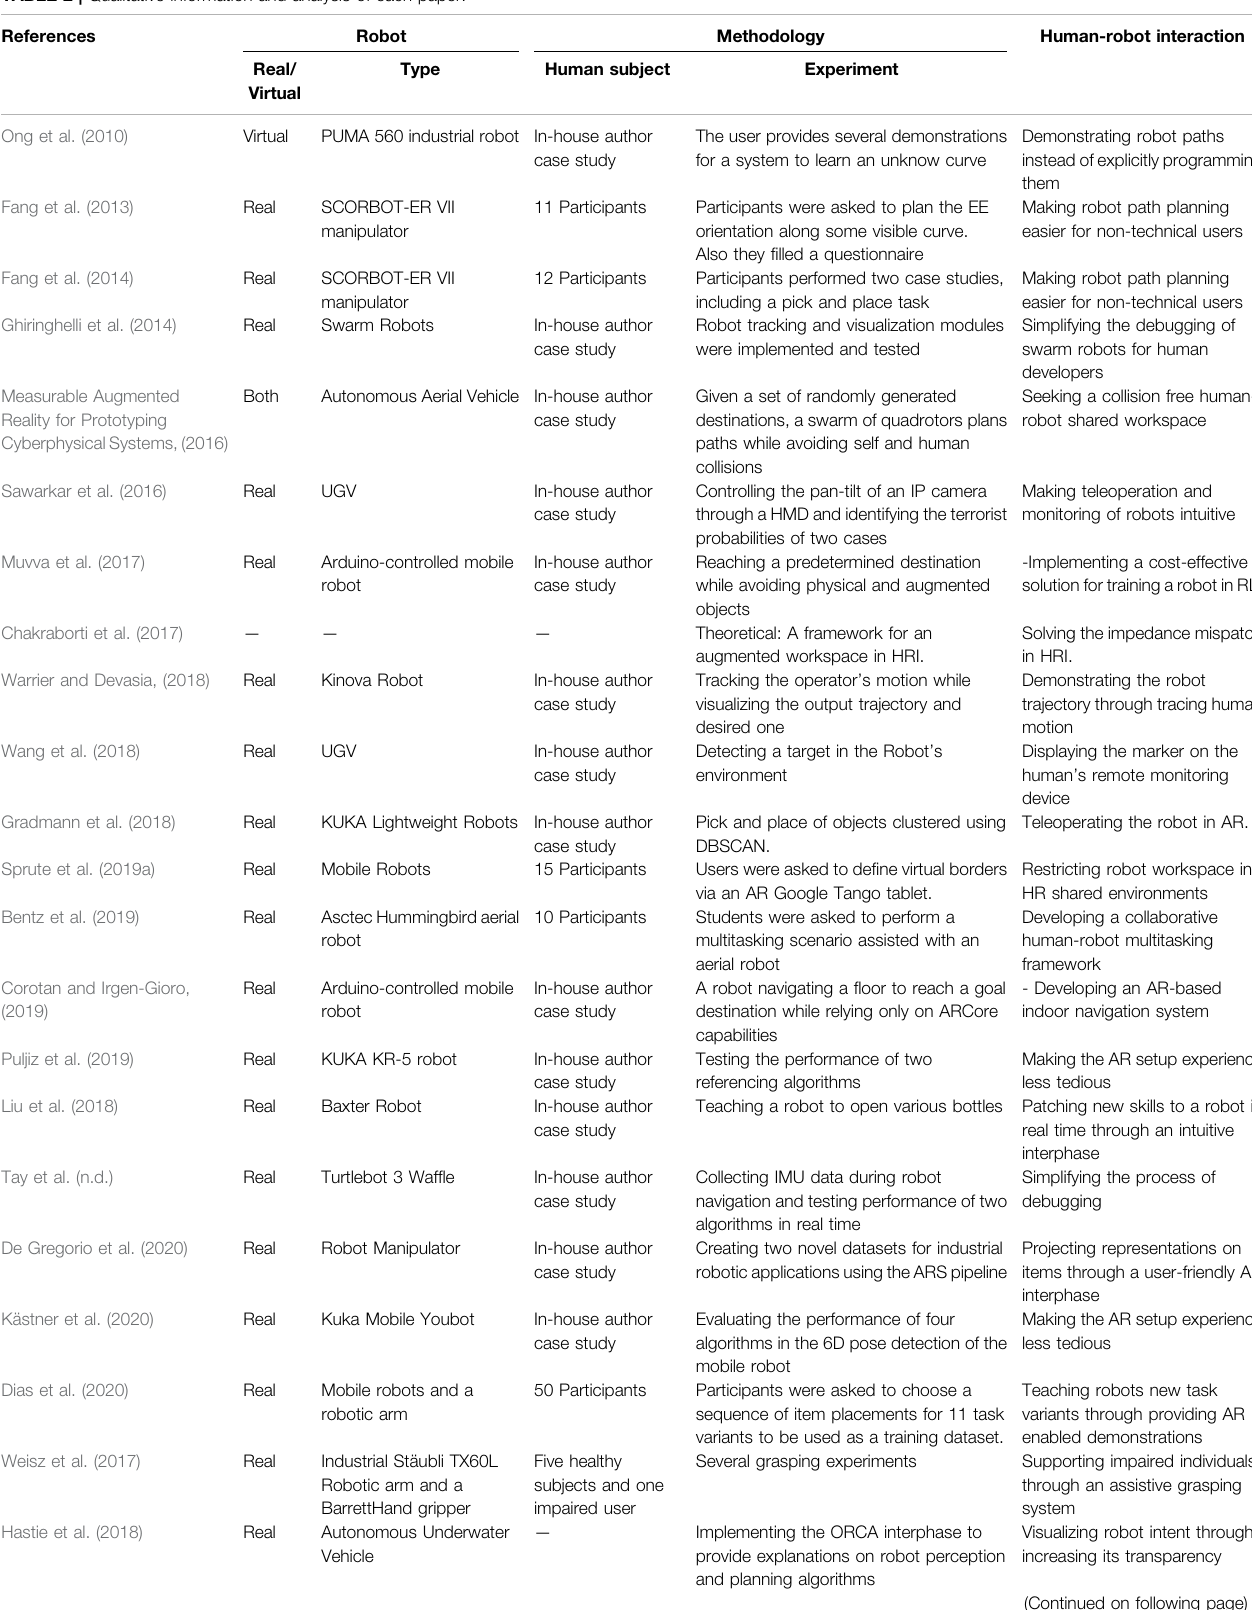
TABLE 2 | Qualitative information and analysis of each